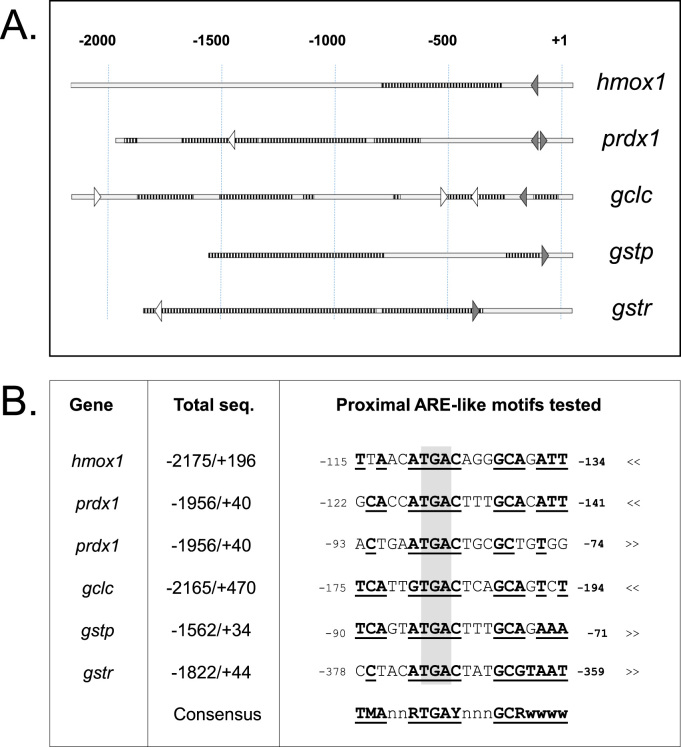
Proximal promoter sequences of coho contain putative ARE-like elements. (A) Schematic of proximal sequences from coho tested in reporter assays. Striated bars indicate regions of repetitive and open bars non-repetitive sequence. Triangles represent matches to core ARE (RTGAYNNNGC), right- or left-facing indicate forward or reverse orientation, respectively, and those filled represent elements examined in this study. Numbering is approximate to putative transcription start sites based on cDNA data available for Salmo salar [GenBank BT047880 (hmox1), NM_001141386 (prdx1), BT058249 (gstp), BT057296 (gstr); CSSEST2 database, id SS2U041775 (gclc)]. (B) Alignment of proximal coho ARE motifs with mammalian consensus. Putative ARE elements from coho genes examined in this study. Bases in agreement to consensus sequence underscored and bold. Numbers represent approximate position relative to transcription start in forward (>>) or reverse (<<) orientation. Shaded box indicates mutation target: TGA→ATT (hmox1 and gclc) or TGA→CCC (prdx1, gstp, gstr). Region of flanking sequence tested in pGL3 luciferase reporter constructs, middle column. Consensus: (M = A or C, R = A or G, Y = C or T, W = A or T) [57].